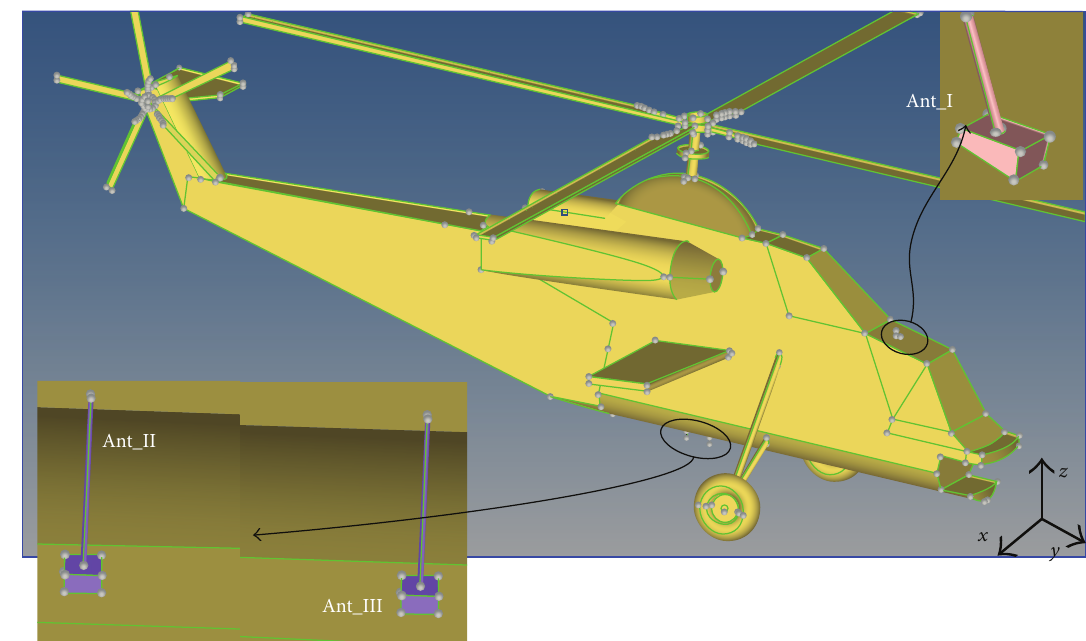
Figure 8: The geometry of the antennas mounted on a complex